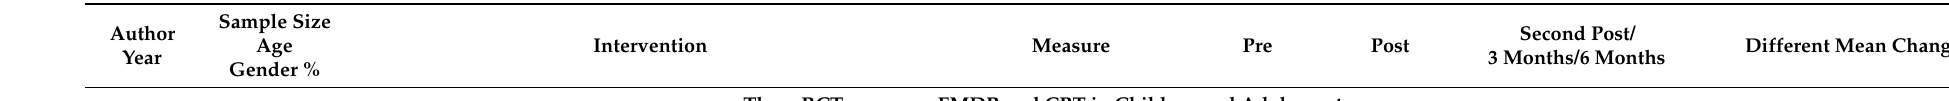
Table 2. Characteristics and outcomes of the included